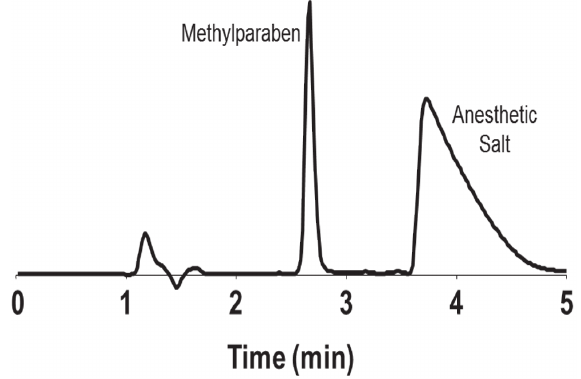
Figure 2- Chromatogram of one sample of local anesthetic for dentistry. Chromatographic conditions: acetonitryle:water (75:25 - v/v), pH 4.5, flow rate: 1